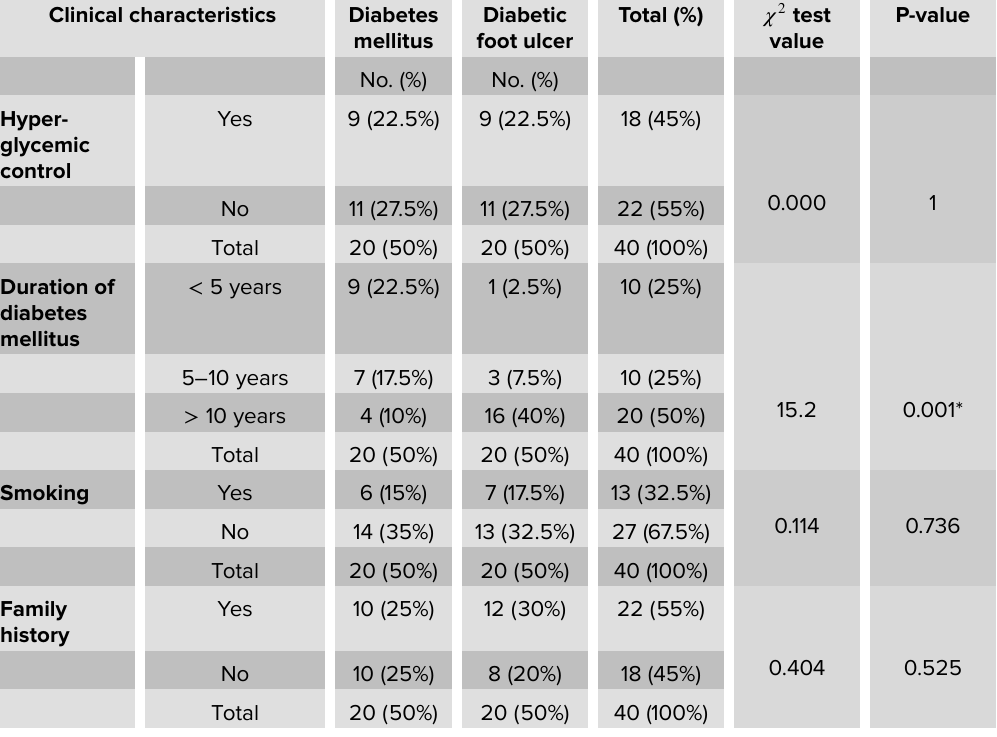
TABLE 2: Frequencies and percentages of diabetic and DFUs patients in relation to clinical